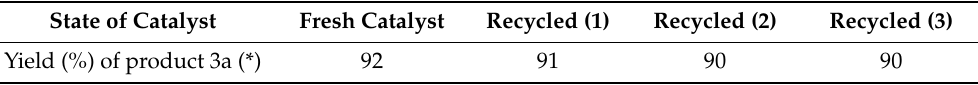
Table 2. Recyclability of PVA-Al 2 O 3 nanocomposites as basic